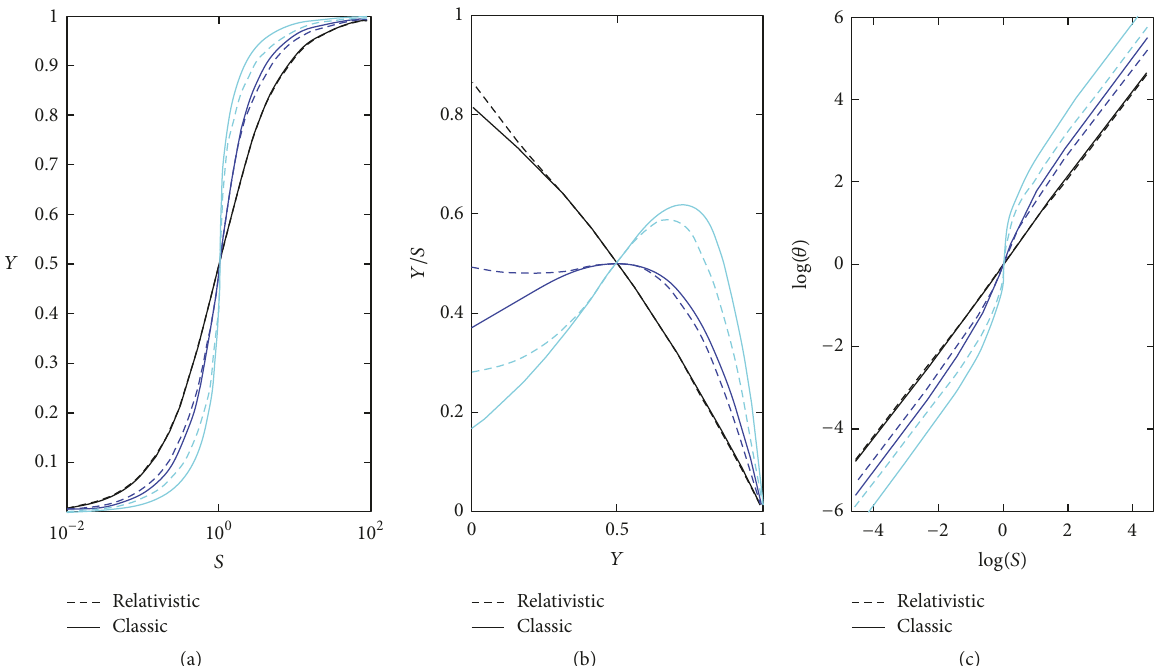
Figure 3: The role of the interaction coupling 𝐽 . We resume the plots presented in (a)–(c) of Figure 2 and we show how they are affected by the interaction coupling 𝐽 . In particular, we compare the outputs for 𝐽 = 0.1 (black), 𝐽 = 0.5 (blue), and 𝐽 = 0.9 (bright blue). Again, the relativistic model (dashed line) and the classical model (solid line) are compared. Notice that the gap between relativistic and classical model is larger when 𝐽 is relatively